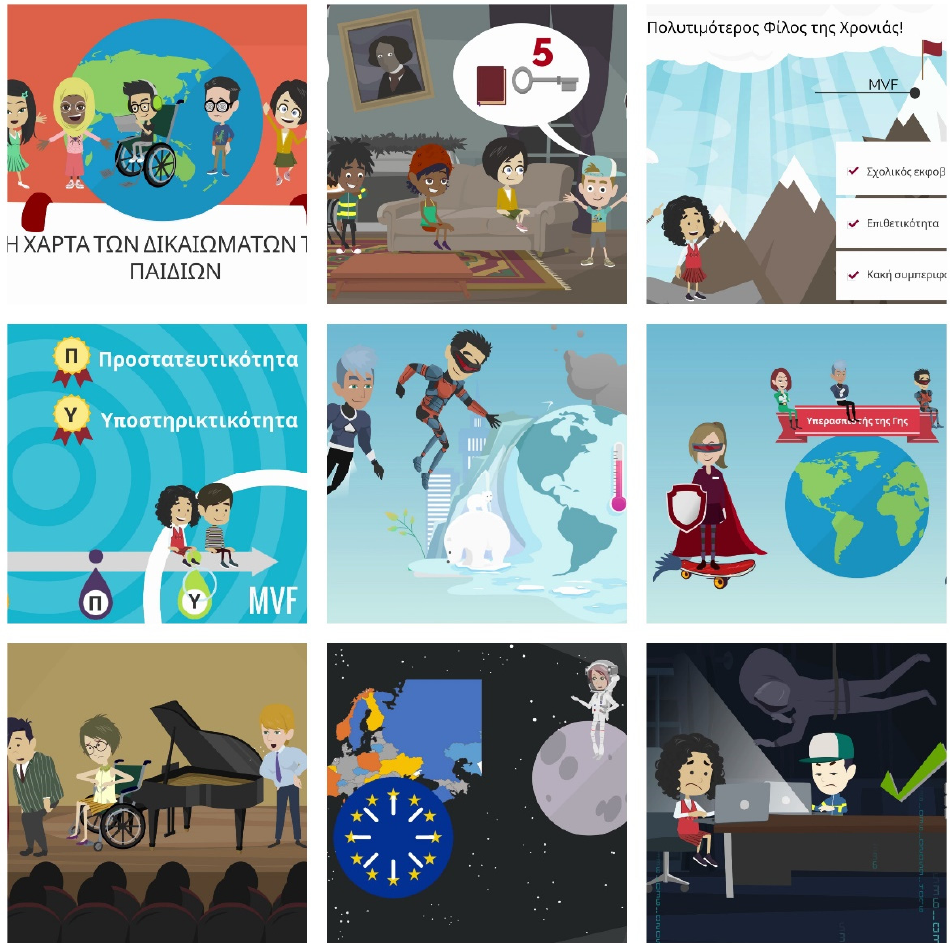
Figure 1. Snapshots from modules’ playful narratives: Children rights chart (A1); Collaborative escape from the haunted castle (A1); MVF depicted metaphorically as a mountain peak that students can reach (A2); Friendship progress bar and badges (A2); Superheroes against climate change (A4); Earth defender gear (A4); the dismissal of divergent persons (A5); Interstellar communication with the galaxy Europe-21 (A6); Invisible Internet threats visualized as obscure hacker Dr Megavirus machinations (A7).